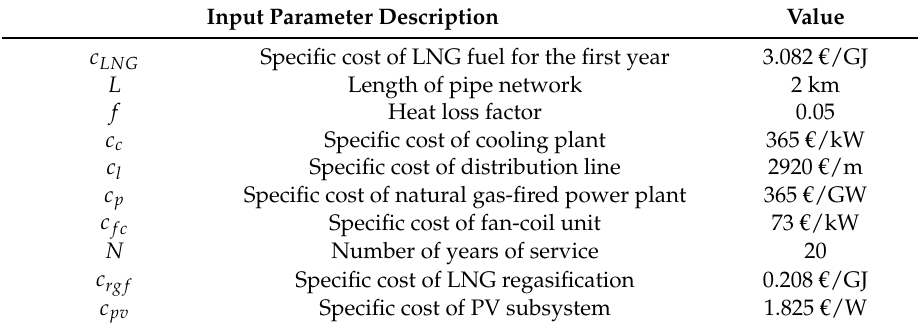
Table 4. Input values for the cost